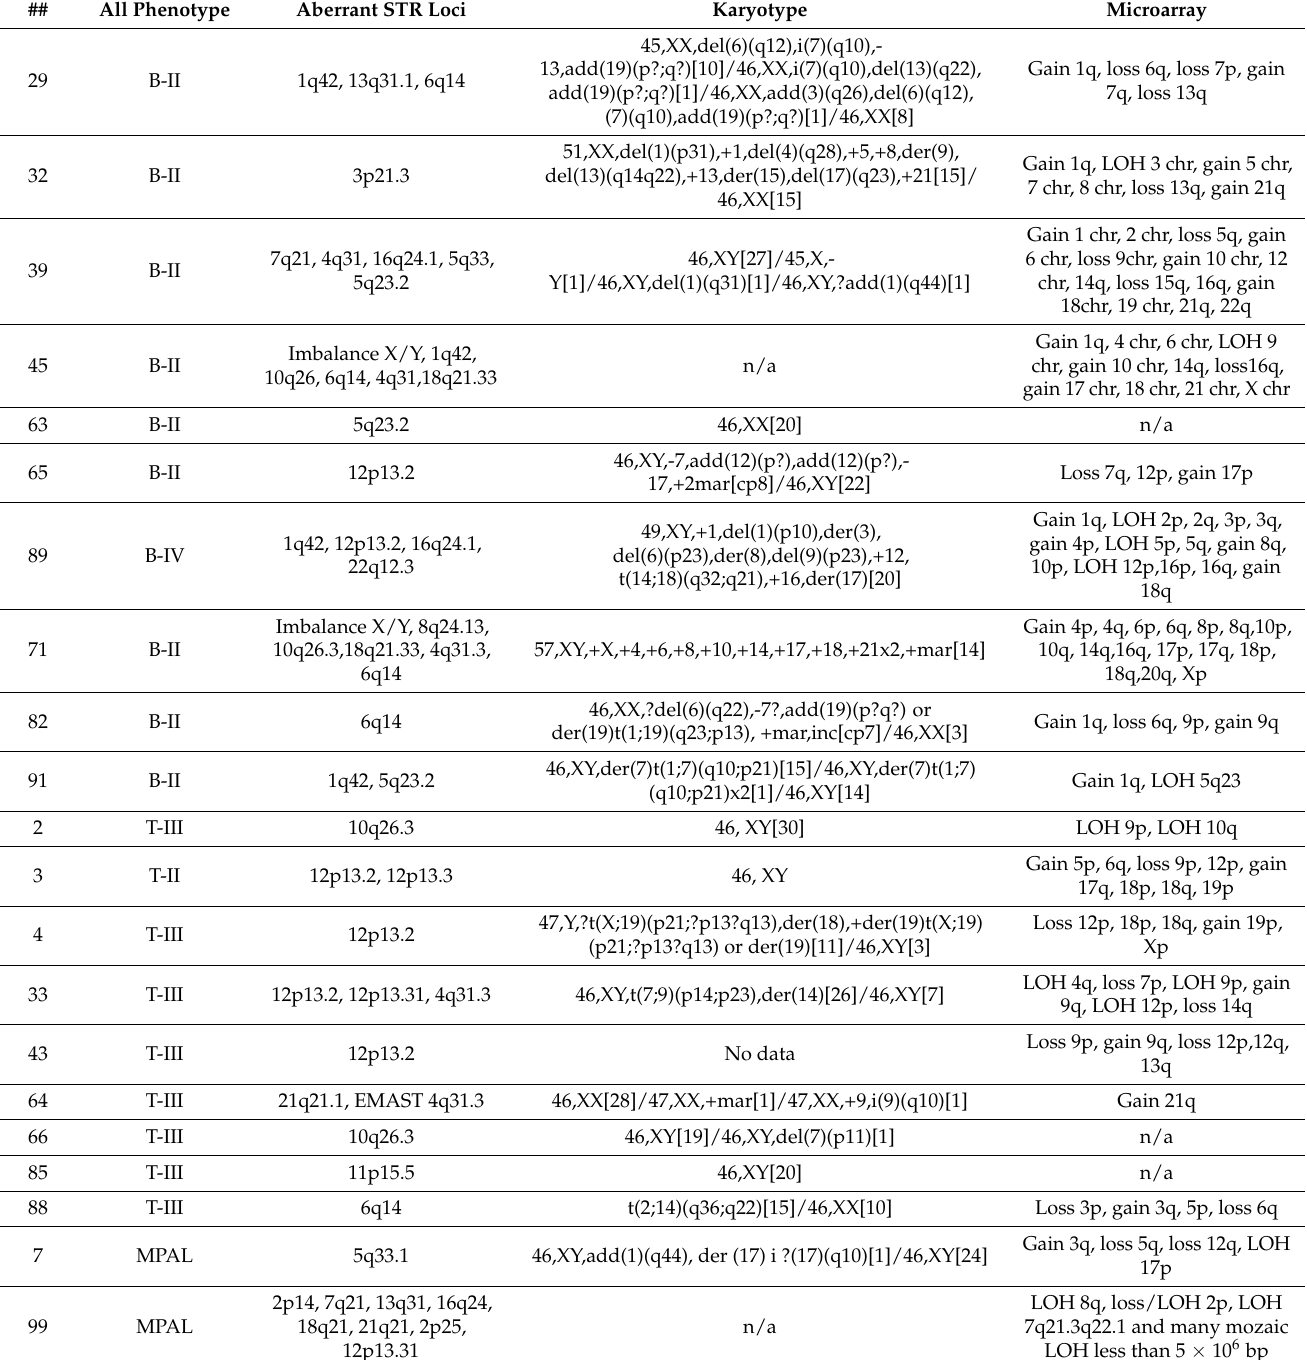
Table 4. The karyotypes and microarray data of the patients with aberrant STR profiles in tumor